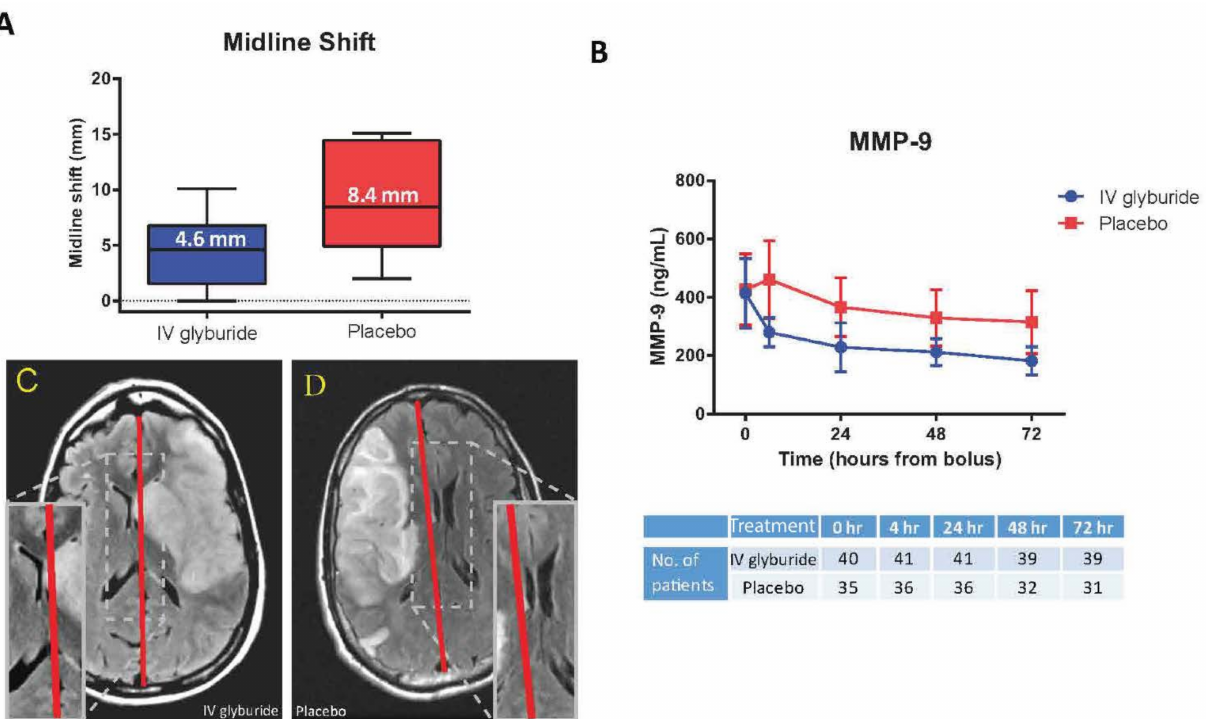
Figure 5. Figures from the GAMES-RP clinical trial demonstrating the effect of glyburide on midline shift ( A , C , D ) and plasma MMP-9 levels ( B ). ( A ) Boxplot showing the median midline shift (horizontal line, box = interquartile range, whiskers = 10–90 percentile) in each treatment group in the per-protocol sample. ( B ) Temporal profile of mean total plasma MMP9 levels for the per-protocol sample (error bars are 95% confidence intervals at the specific timepoint shown). ( C , D ) Representative examples of median extent of midline shift on follow-up brain MRI with a patient treated with intravenous glyburide (5 mm) vs a placebo-treated patient (9 mm). The redline is a reference showing the brain midline. Adapted with permission from Ref.